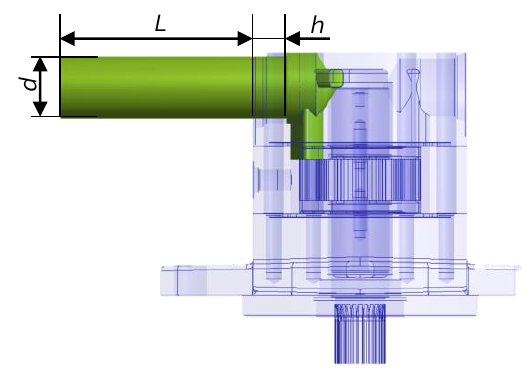
Fig. 4. The investigated flow